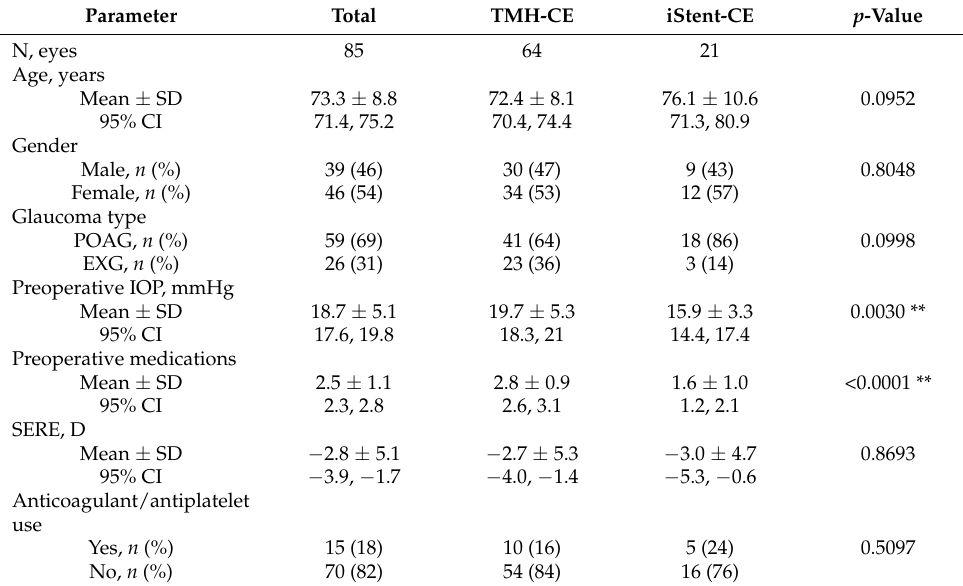
Table 2. Demographic